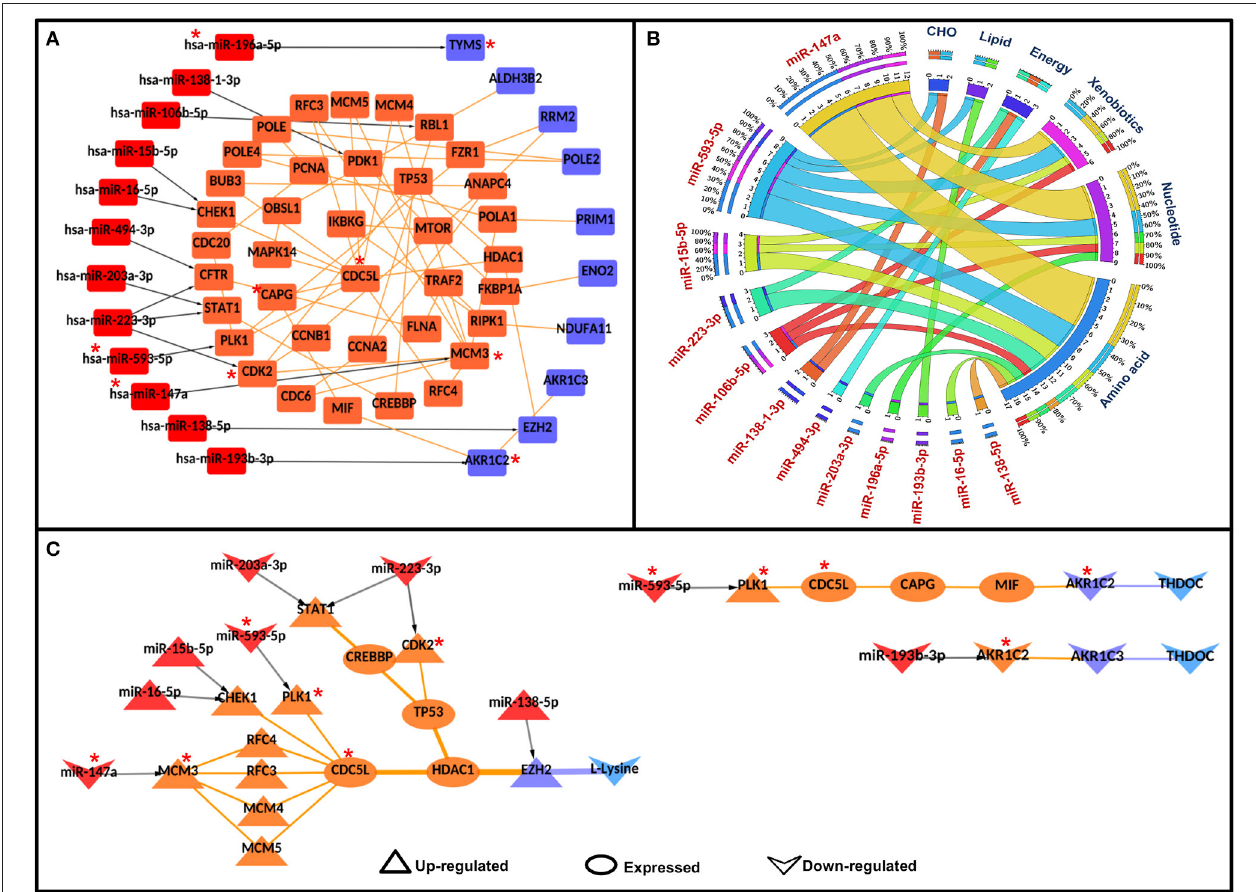
FIGURE 5 | Significant miR-metabolic pathway interconnecting paths/network in cervical cancer. (A) represents a significant miRNA metabolic interaction network, (B) shows the miRNA to metabolic pathway interconnectivity, and (C) shows the significant miRNA to metabolic paths regulating metabolites in cervical cancer. Terminal miRNAs and metabolic enzymes are colored in red and blue. Protein-protein interactors are colored in orange. Gene regulatory edges are represented as black arrows and protein-protein interactions are represented by orange edges. Nodes with an asterisk (*) are key or effector nodes in the significant